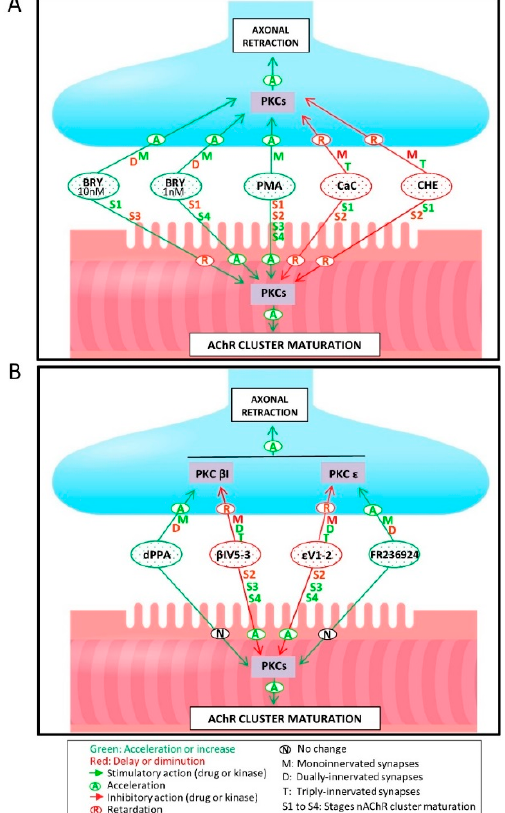
Figure 5. Stimulation and inhibition of PKC modifies the postsynaptic receptor cluster during postnatal Figure 6. Diagrammatic representation of PKC involvement in synapse maturation. ( A ) shows the maturation. The histogram in ( A ) shows that the unselective stimulation and inhibition of PKC a ff ects effect on axonal retraction and nAChR cluster maturation of the unselective PKC inhibitors and PKC the maturation of the postsynaptic nAChR clusters. Inhibition with CHE or with CaC results in the stimulators. ( B ) shows the effect of the nPKC ε and cPKC β I (modulators). persistence of the immature S1 clusters. Accordingly, PMA (10 nM) accelerates postsynaptic maturation and a similar e ff ect is observed with BRY (1 nM). However, 10 nM BRY downregulates the PKC at the postsynaptic site. ( B ) shows that the specific stimulation and inhibition of cPKC β I and nPKC ε isoforms a ff ects the maturation of the nAChR clusters. Blocking these kinases accelerates postsynaptic maturation though the selective stimulation with dPPA and FR 236,924 respectively show no influence on the maturation of the nAChR clusters. Data were presented as mean ± SD (for each treatment and PBS control: n pups = 6; n = 12 LALs). Fisher’s test: * p < 0.05, ** p < 0.01, *** p <